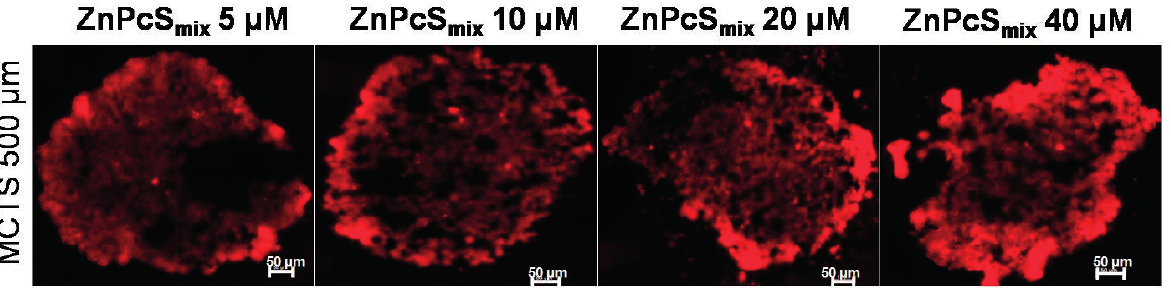
Figure 1. The fluorescence pattern of Zinc Sulfophthalocyanine (ZnPcS mix ) in multicellular tumour spheroids (MCTSs) with 500 µm. MCTSs treated with a concentration of 40 µm exhibited more red fluorescence intensity as compared to other concentrations. Scale bar denotes 50